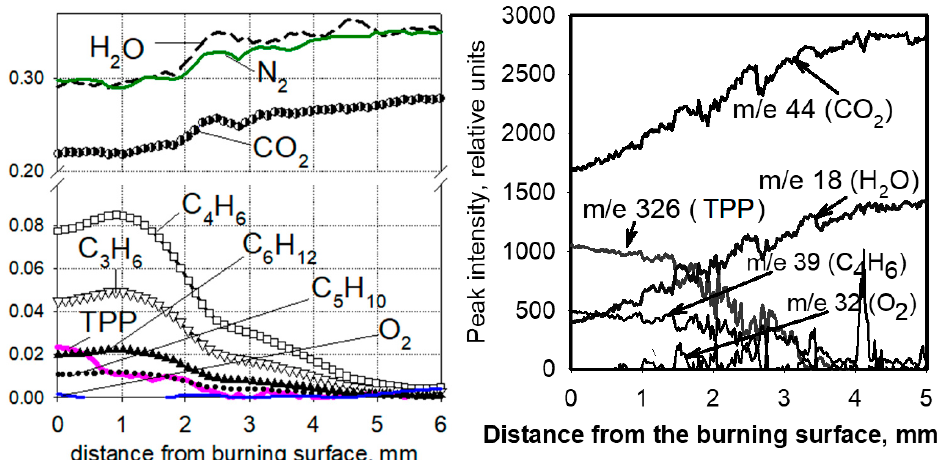
Figure 19. Species concentration profiles in the diffusion flame of samples of UHMWPE + 10% TPP (left) and HDPE (3.8×10 5 ) + 10% TPP (right).